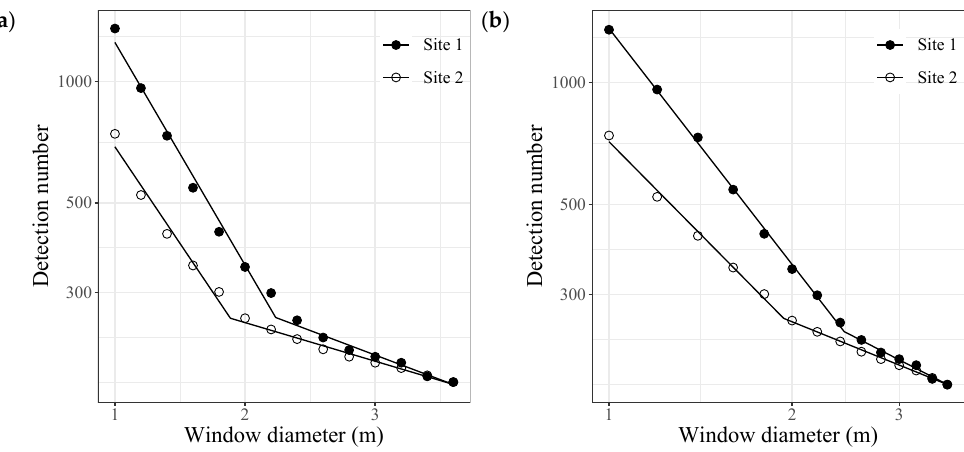
Figure 3. Number of detected treetops against the diameter of the moving window at sites 1 and 2. The tipping points between the bilinear regression lines are the optimal widow size. ( a ) is in a semi-logarithmic scale (normal scale for window diameter), and ( b ) is in a double logarithmic scale.